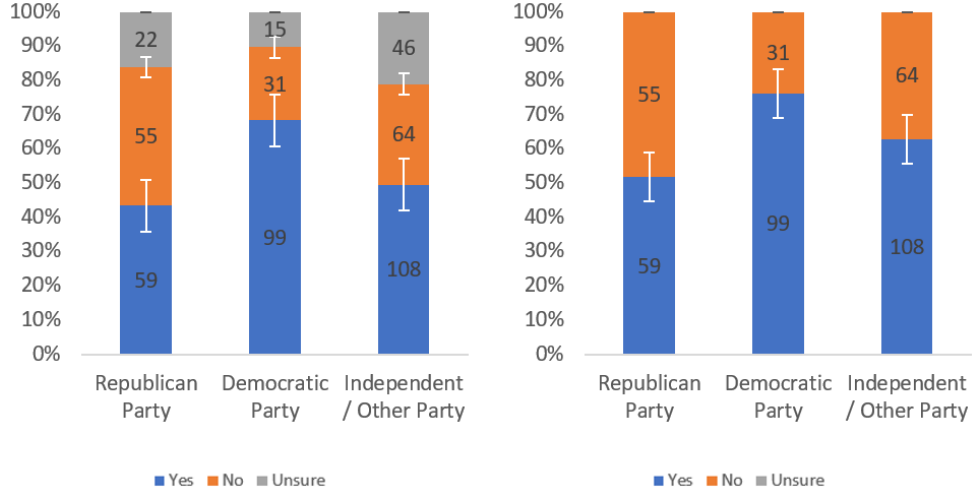
Figure A8. Responses regarding respondents’ willingness to review by party affiliation including ( left ) and excluding ( right ) unsure responses.